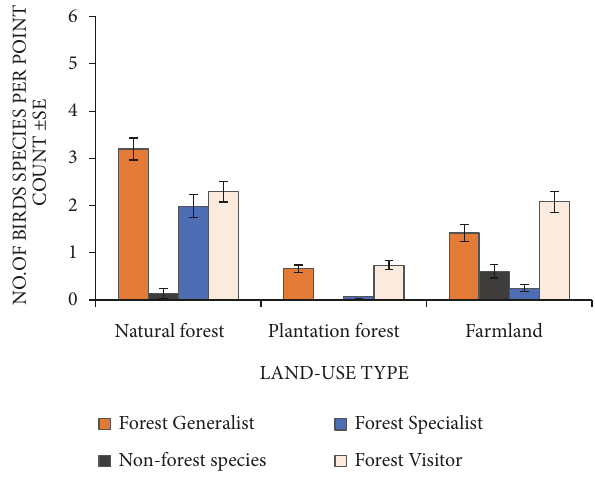
Figure 3: Influence of land-use type on bird species richness and forest dependent guilds.